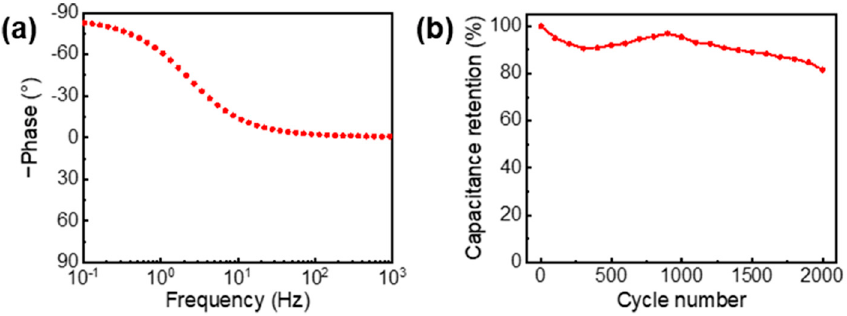
Figure 6. Nyquist plots of the supercapacitors using AG/rGO deposited on ( a ) P-Cu, ( b ) R-Cu, and ( c ) B-Cu mesh electrodes. The frequency ranges from 50 kHz to 0.1 Hz.